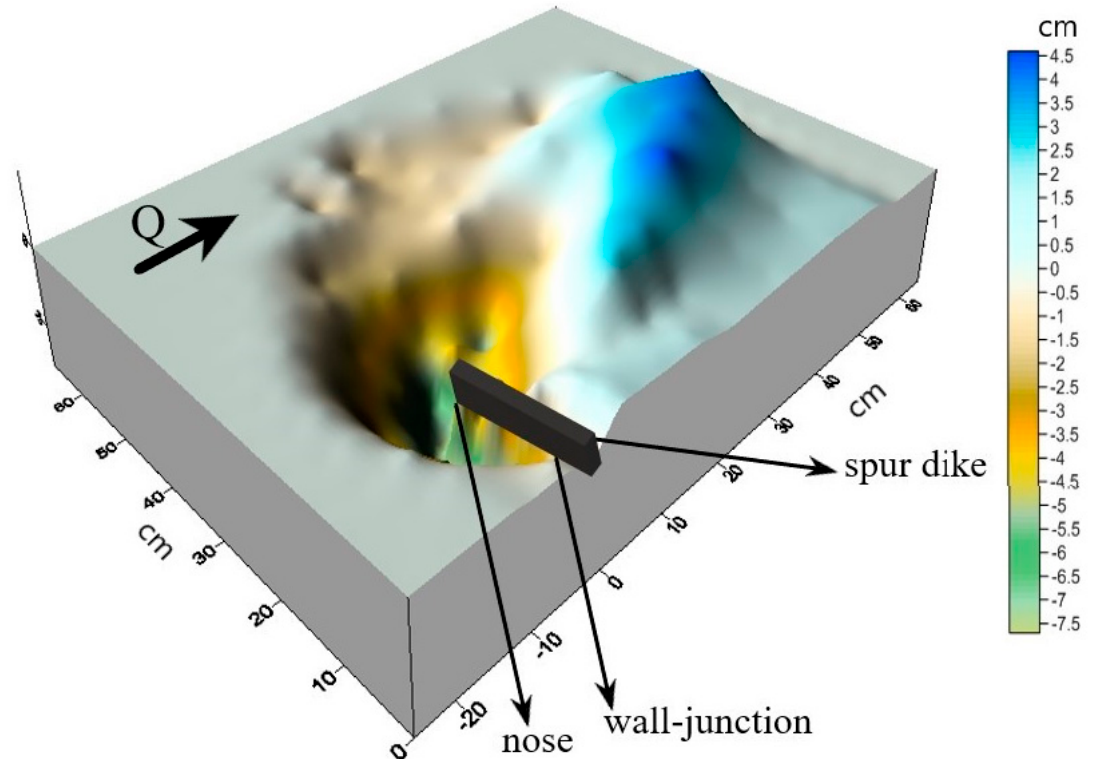
Figure 3. Geometry of scour hole at equilibrium condition for R10.